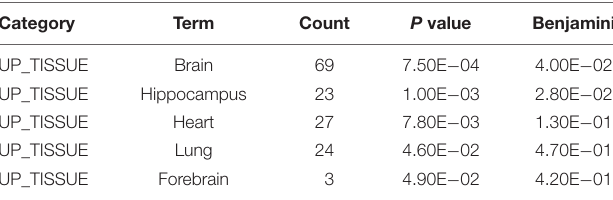
TABLE 3 | Tissue-specific analysis of the target genes of differential expression microRNAs using DAVID bioinformatics resources. Category